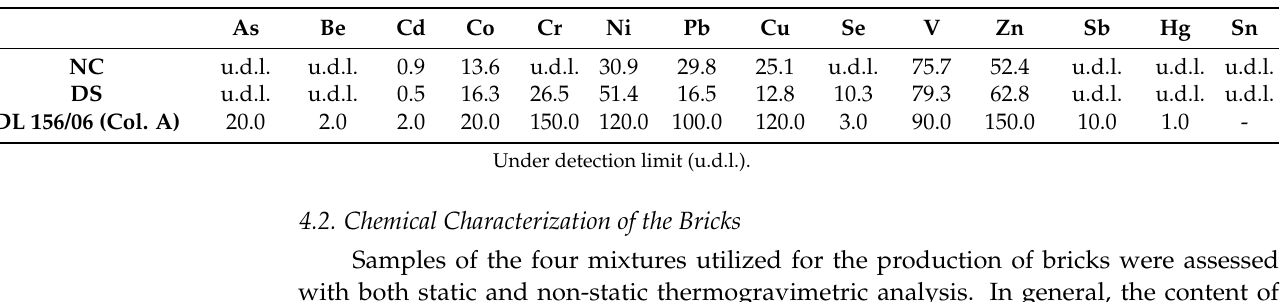
Table 3. Minor chemical components (in ppm) in row materials, and limit values for the concentration of heavy metals in the soil of both public and private green